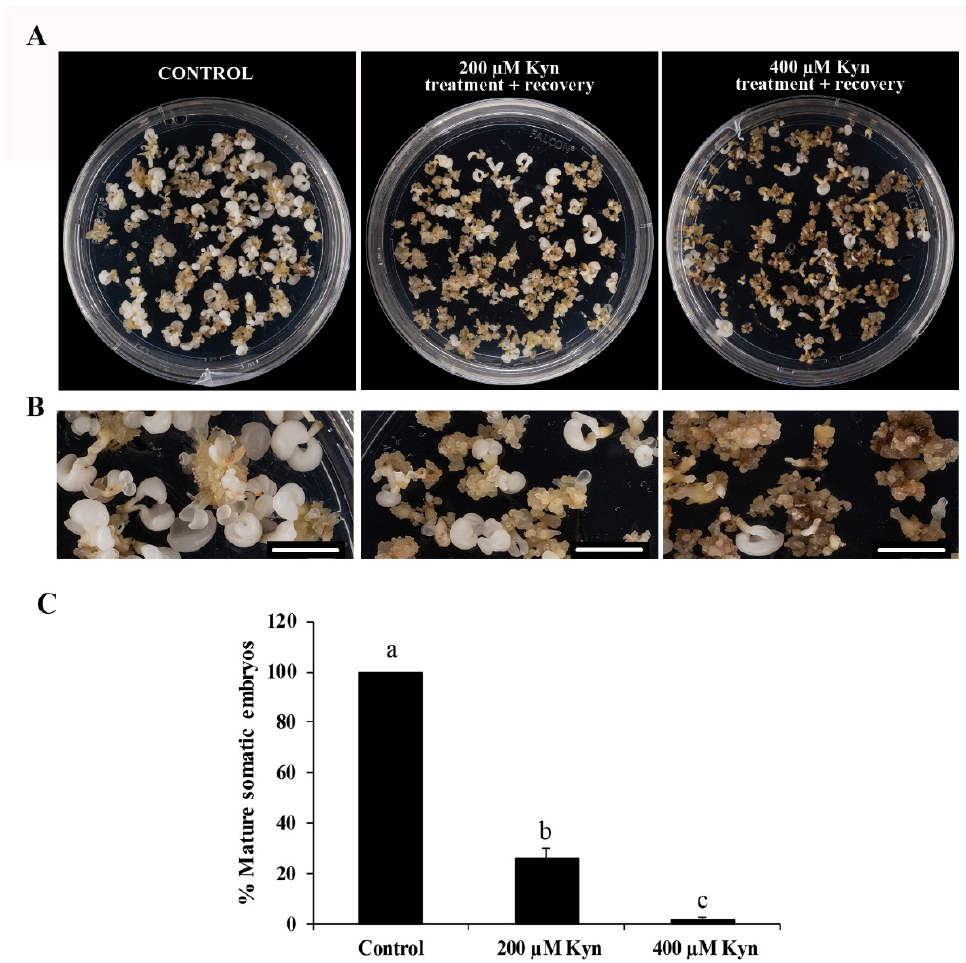
Figure 6. Effect of kynurenine on the recovery of SE cultures. ( A ) Cultures after 30 days in recovery conditions. Left picture: control cultures; central picture: 200 µ M kynurenine-treated cultures in recovery; right picture: 400 µ M kynurenine-treated cultures in recovery. ( B ) Detail at higher magnification of cultures after 30 days in recovery conditions. Left picture: control cultures; central picture: 200 µM kynurenine-treated cultures in recovery; right picture: 400 µM kynurenine-treated cultures in recovery. ( C ) Quanti fi cation of embryos produced after 30 days in recovery conditions in control cultures and cultures treated with kynurenine. Columns represent mean values of the percentage of mature somatic embryos; bars represent the standard error of the mean. Di ff erent le tt ers in the columns indicate signi fi cant di ff erences according to ANOVA and Tukey’s test at p ≤ 0.05. Bars represent 1 cm.